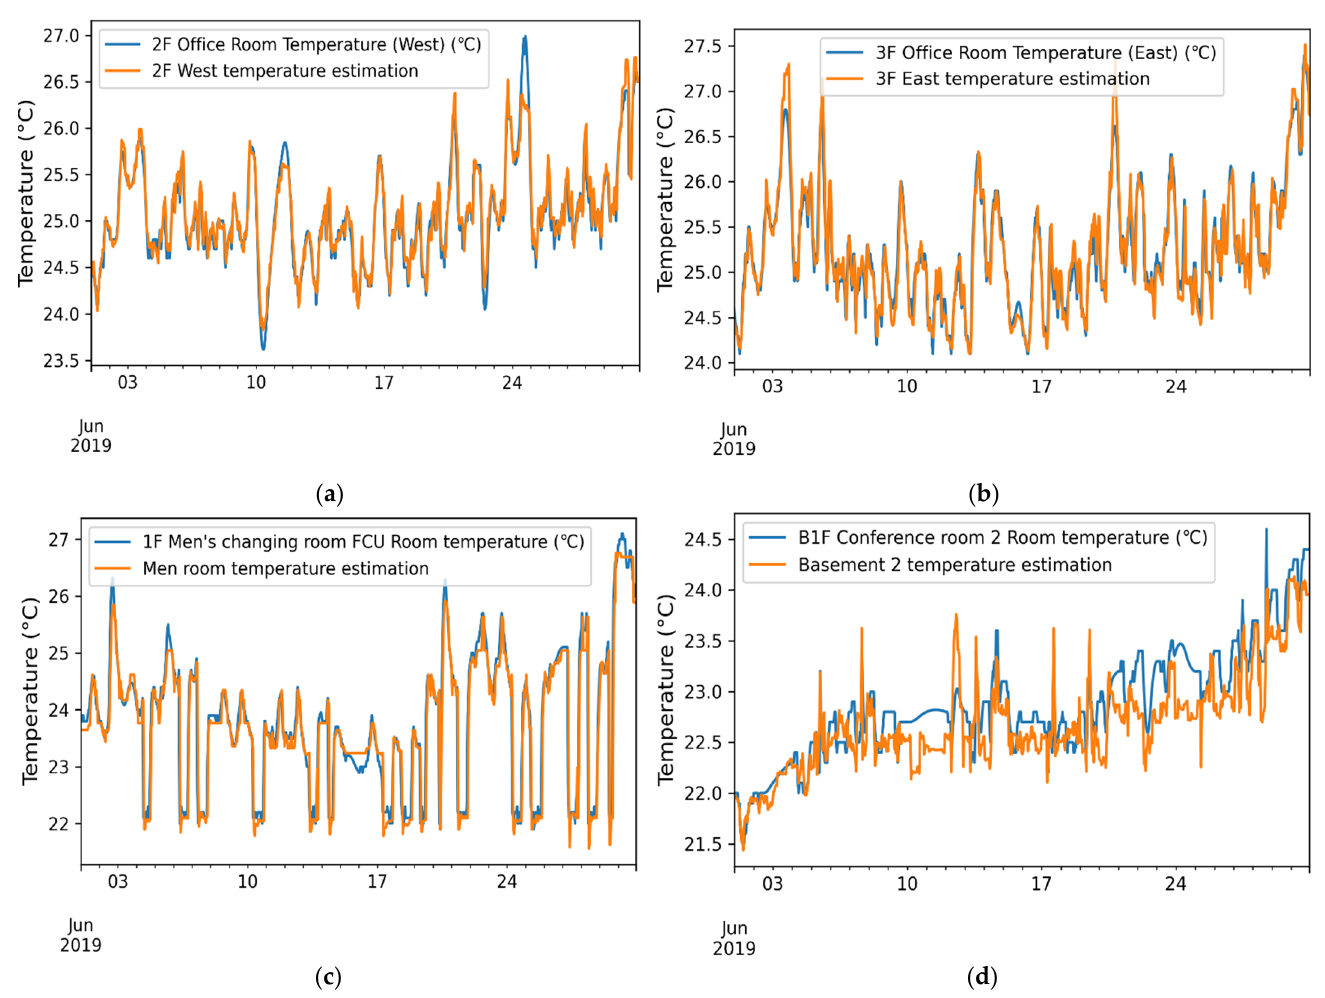
Figure 6. ( a ) Plot of actual 2F office room temperature and its estimation for June 2019; ( b ) plot of actual 3F office room temperature and its estimation for June 2019; ( c ) plot of actual 1f Men’s changing room temperature and its estimation for June 2019; ( d ) plot of actual B1F conference room 2 temperature, and its estimation for June 2019.